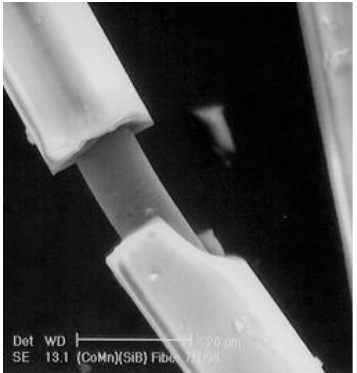
Figure 2. Micrograph of the glass-coated microwire